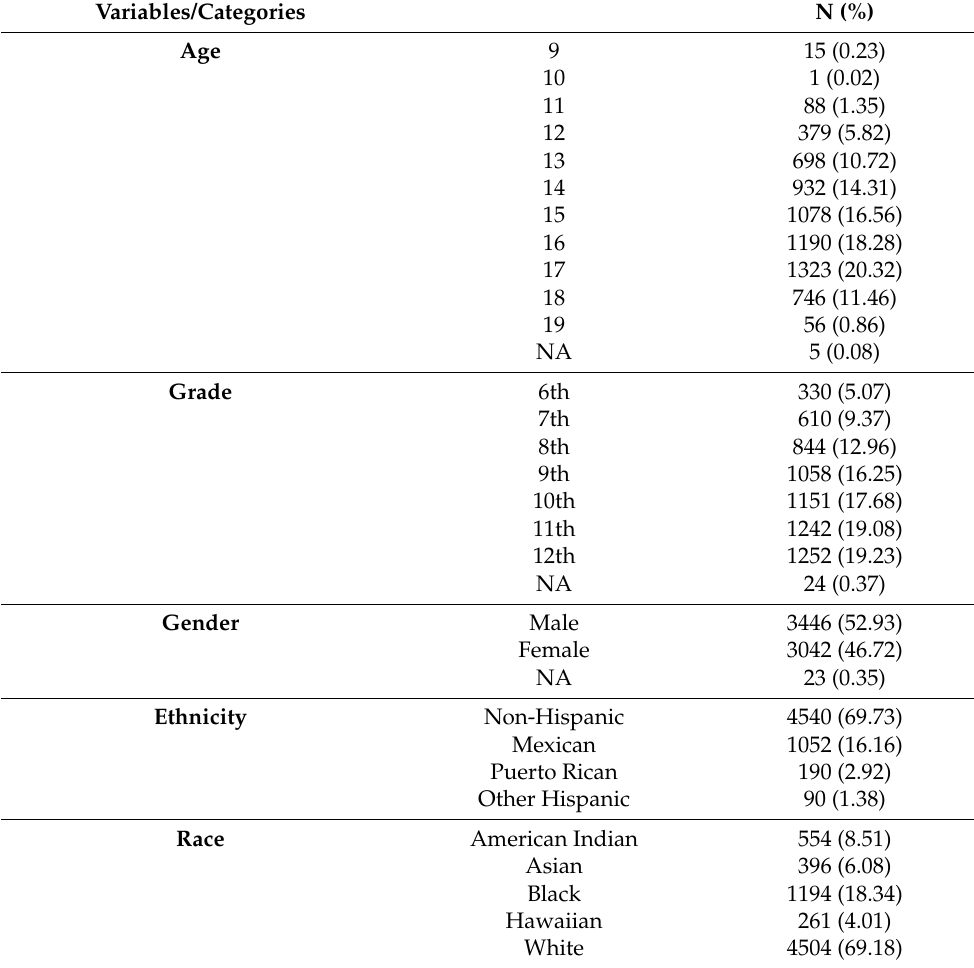
Table 1. Characteristics of study participants (N =